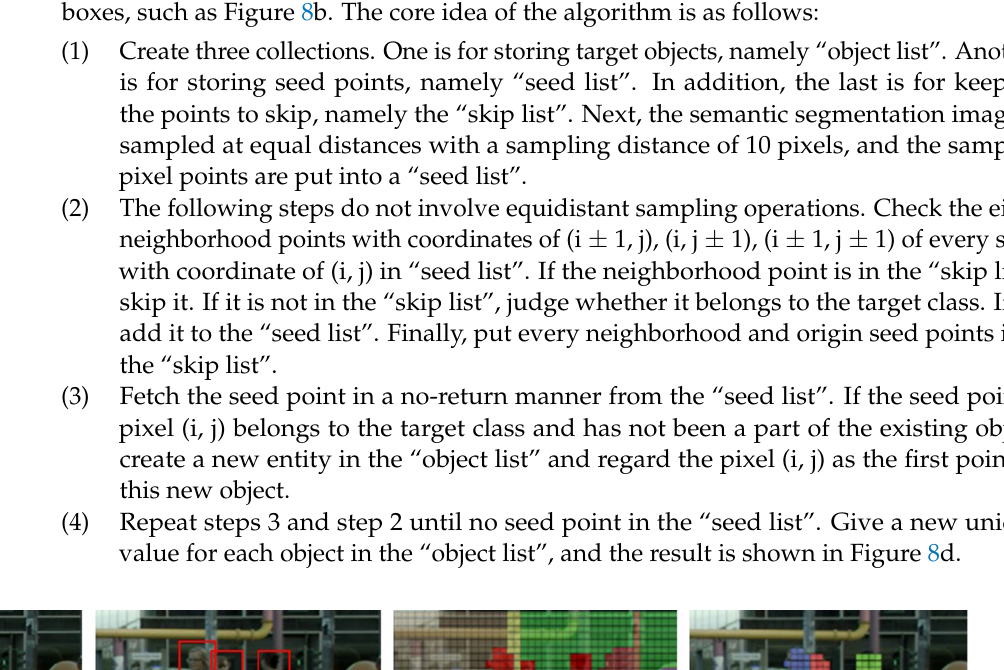
Table 4. The screening criterion for each type of suspected scenarios. Category Rules for the Recognition HS1